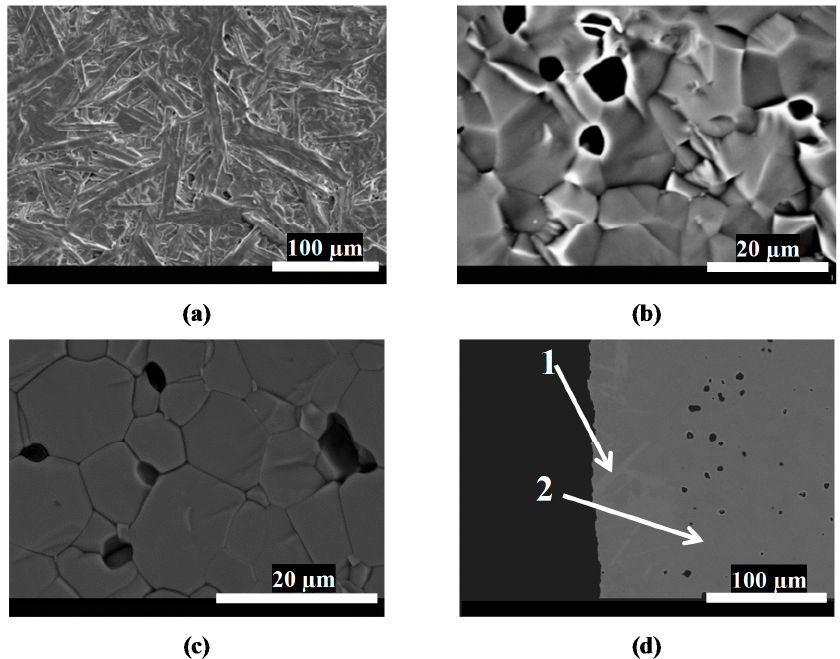
Figure 6. SEM micrographs of BCZN ceramics ( S1 ): ( a ) of a surface; ( b ) of a fractured surface; ( c ) of a grain boundary; and ( d ) of a longitudinally polished section.